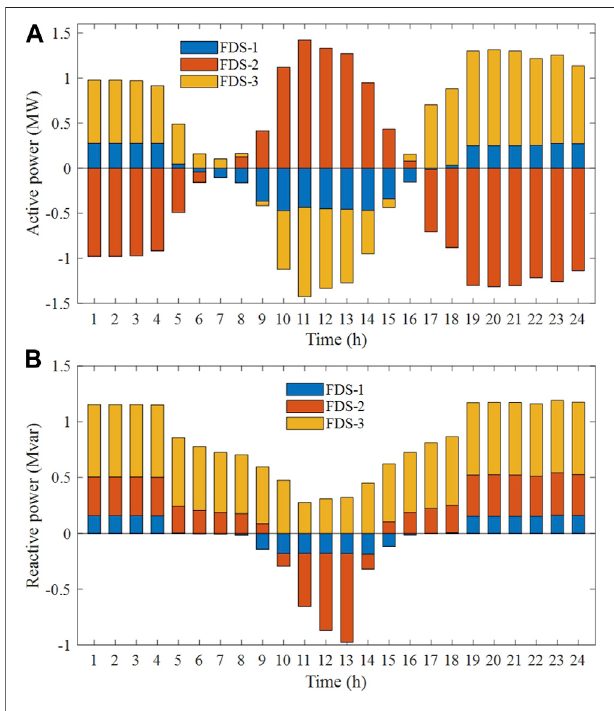
FIGURE 10 | Daily power pro fi les of FDS. (A) Active power (B) Reactive power.